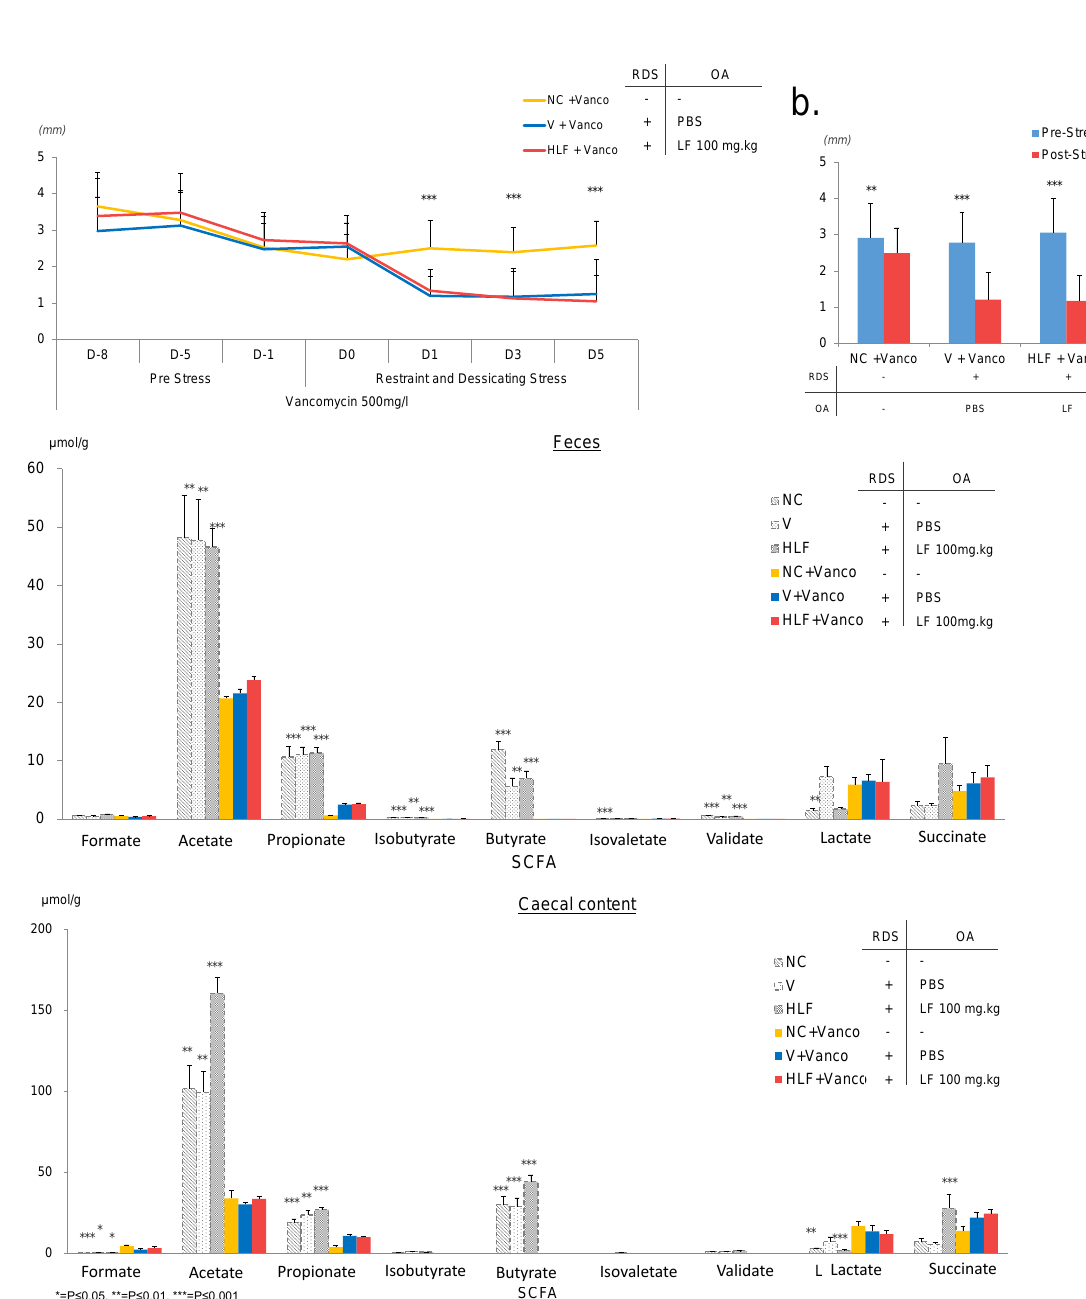
Figure 4. Influence of vancomycin on the effects of lactoferrin. To assess the influence of LF-mediated modulation of the gut microbiota on our PRTT observations, we modified our RDS protocol. Mice were administered the antibiotic, vancomycin, (500 mg/L) in their drinking water to induce gut dysbiosis and, therefore, potentially decrease the effects of LF on the gut microbiota. Mice were preloaded with vancomycin (in drinking water) for 1 week prior to the initial stress. Daily RDS commenced from day 0. Three groups of mice were used, NC + Vanco, V + Vanco, and HLF + Vanco. ( a ) PRTT measurements indicated a gradual decline for all three groups during the preloading phase. Conversely to no vancomycin administered mice in the original PRTT protocol (Figure 1), after the initial stress event, tear secretion further declined in both groups receiving RDS (V + Vanco and HLF + Vanco), indicating that the effects of LF were abrogated by elimination of vancomycin-sensitive bacteria. ( b ) Bar chart demonstrating the difference in PRTT tear secretion level between the beginning and end of vancomycin preloading period (day -8 to day 0). ( c ) Bar chart demonstrating the difference in PRTT measurements between pre-stress period (day -8 to day 0) and post-stress period (day 1 to day 5). GC/MS analysis of SCFA in caecal and faecal samples of vancomycin administered mice compared to that in non-administered mice. A significant decline of all three SCFA analysed in both samples was observed in the three groups of vancomycin administered mice compared to that in the non-vancomycin administered mice, highlighting the influence of the gut microbiota in the production of